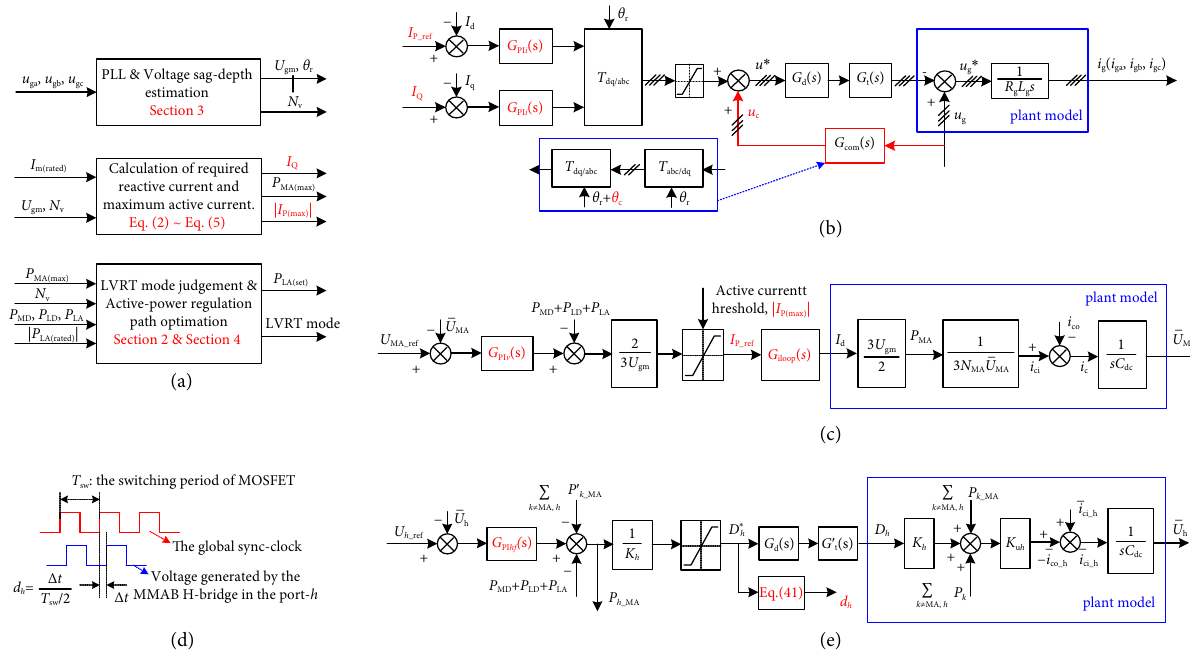
Fig. 9 Block diagram of system control strategies. (a) LVRT strategies. (b) and (c) , inner current loop and outer voltage loop of the grid-connected converter of MVac port, respectively. (d) Definition of the phase-shift ratio of port- h . (e) The control loop of MMAB, h = MD, LD, or